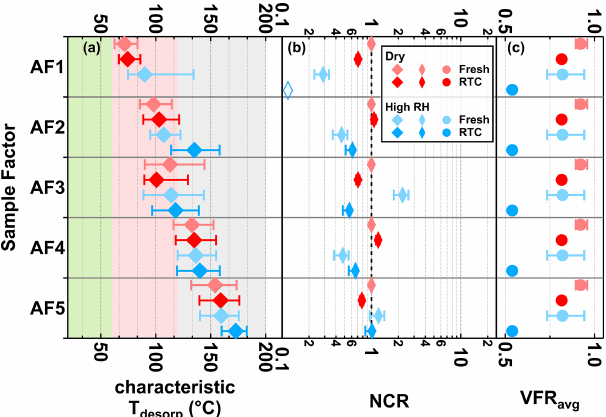
Figure 6. Characteristic desorption temperature (characteristic T desorp with 25th, 50th, and 75th percentiles, a ), net change ratio (NCR, b ) of main sample factors, and mean values of volume frac- tion remaining (VFR avg , c ) of the α -pinene SOA particles at fresh (avg. t R = 0 . 25h) and RTC (avg. t R = 4 . 25h) evaporation stages under dry (red) and high-RH (blue) conditions. Background col- ors in panel (a) indicate the volatility categories derived from the T max − C ∗ calibrations (green – SVOC; red – LVOC; and gray – ELVOC). Note that values of VFR avg are identical in each row of panel (c) . The error bars of NCR represent values accounting for changes in molecular weight and particle density, while those of VFR avg indicate the minimum and maximum values during the FI- GAERO sampling time. If the factor thermogram contributes less than 5% to total signals of sample factors and does not exhibit a clear maximum, the corresponding characteristic T desorp values will not be calculated and the NCR will be indicated by an open rhombus close to